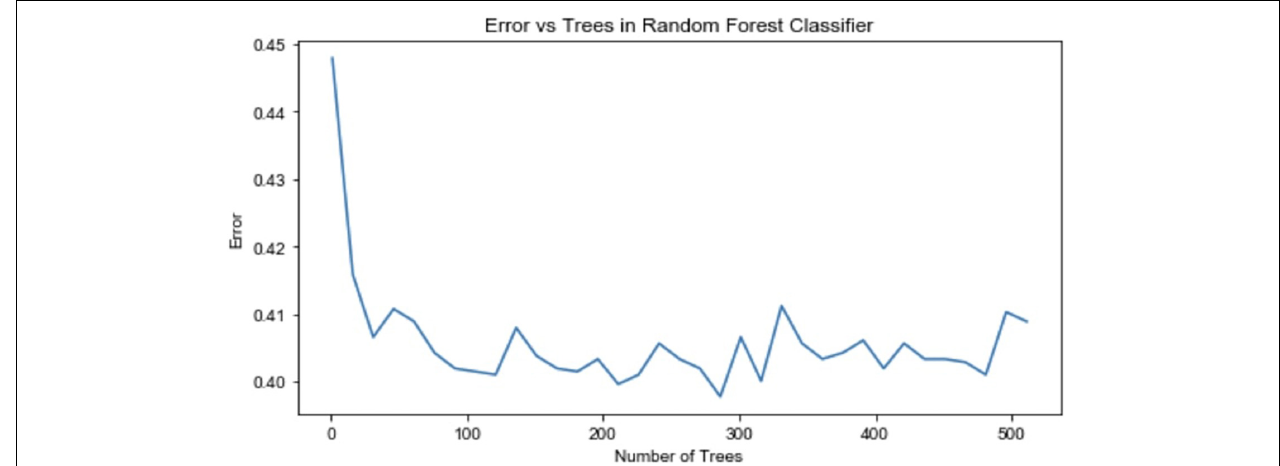
FIGURE 2 | Relationship between the out-of-bag error rate and the number of decision trees.